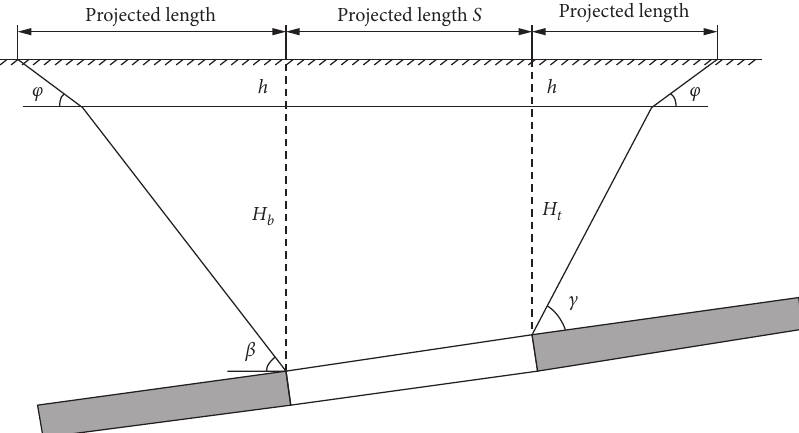
Figure 15: Treatment length of